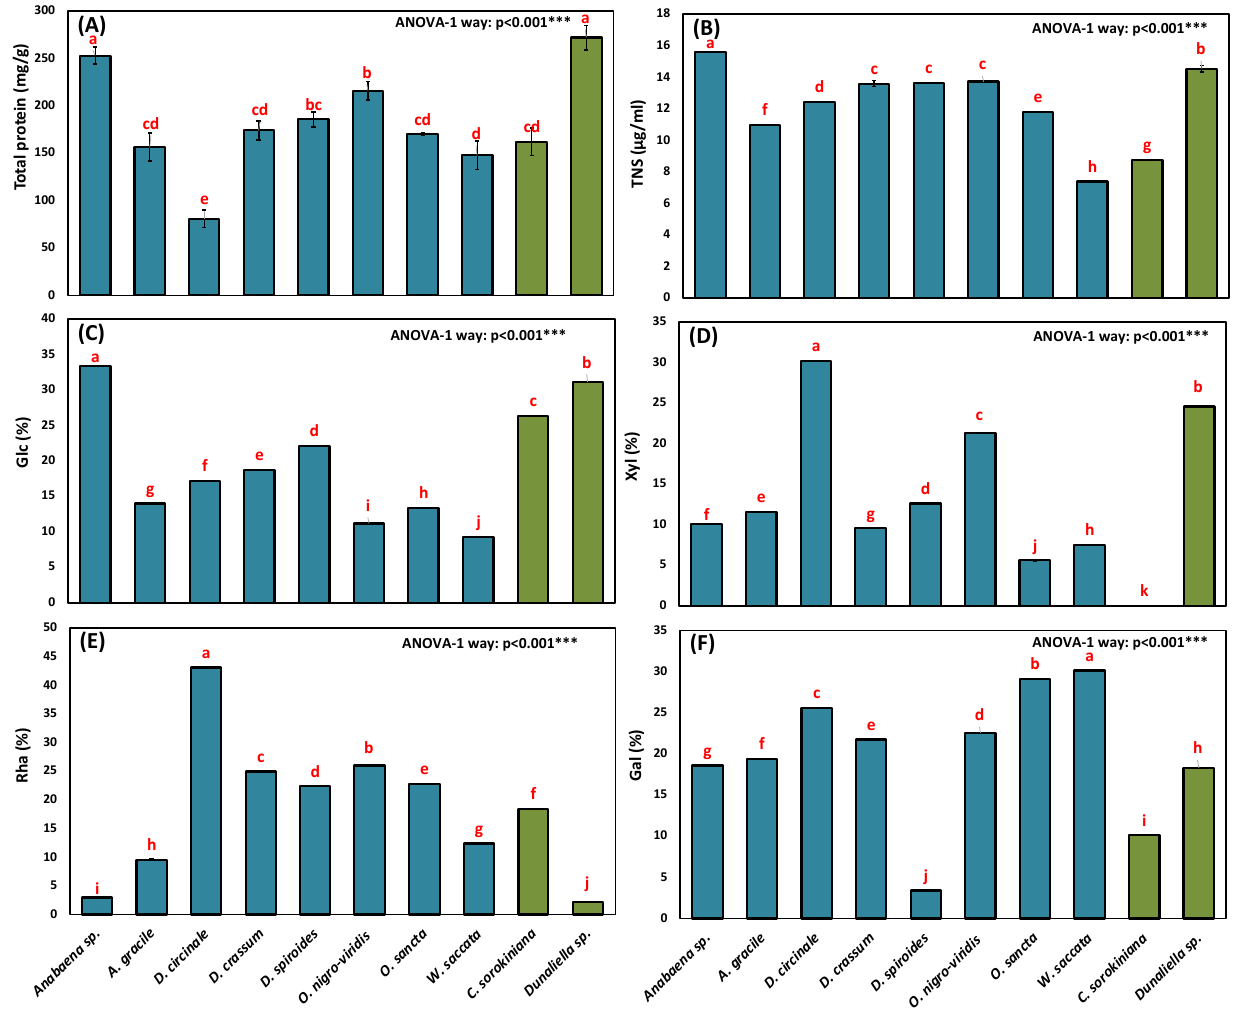
Figure 4. Total proteins, total neutral sugars, and monosaccharide composition (%) were determined from the hydrolyzed exopolysaccharides in the different cyanobacterial and algal strains studied: ( A ) total proteins, ( B ) total neutral sugars (TNS), ( C ) glucose, ( D ) xylose, ( E ) rhamnose, and ( F ) galactose. Bars with different superscript letters were significantly different according to DMRT at p < 0.05. *** significant at p < 0.001.